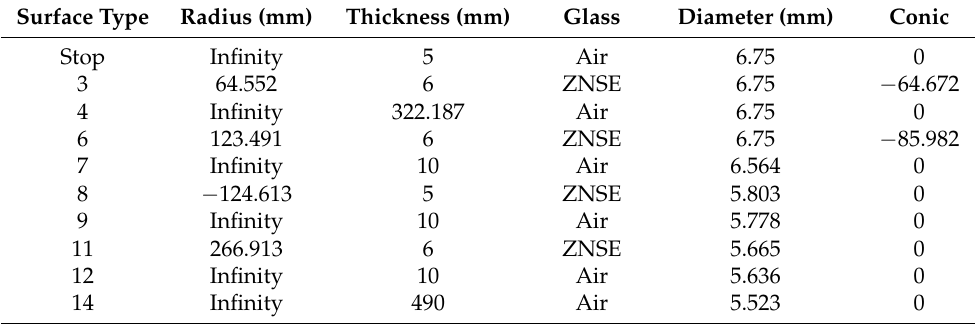
Table 2. Structural parameters of aspherical cylindrical-lens-combined optical system. Surface Type